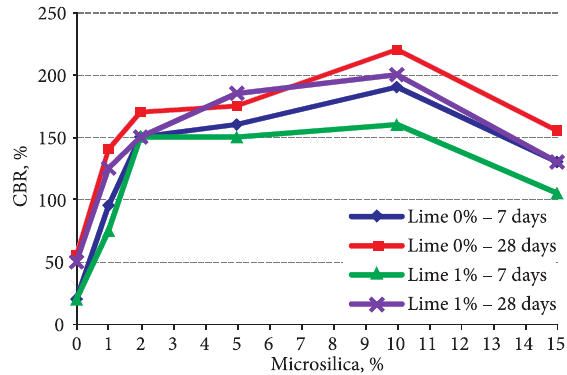
Fig. 7. Effect of adding Microsilica-Lime on CBR with 30 blows for 3% and 5% Lime in saturated